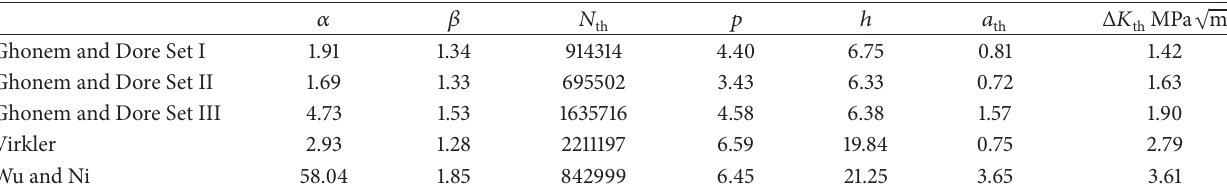
Table 3: Parameter values for the five